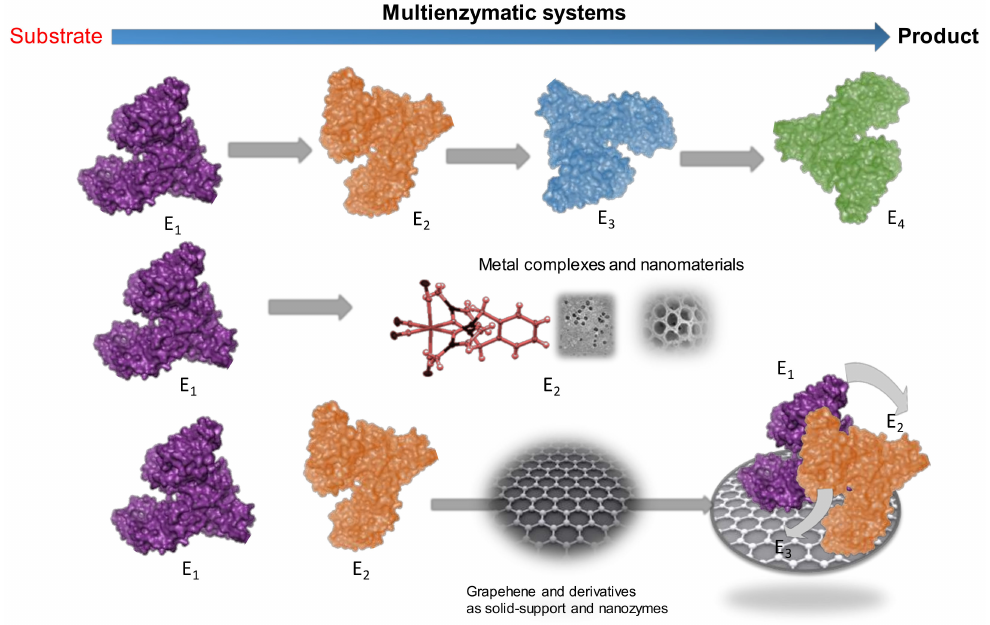
Figure 1. Di ff erent concepts of multi-enzymatic cascade processes. E: